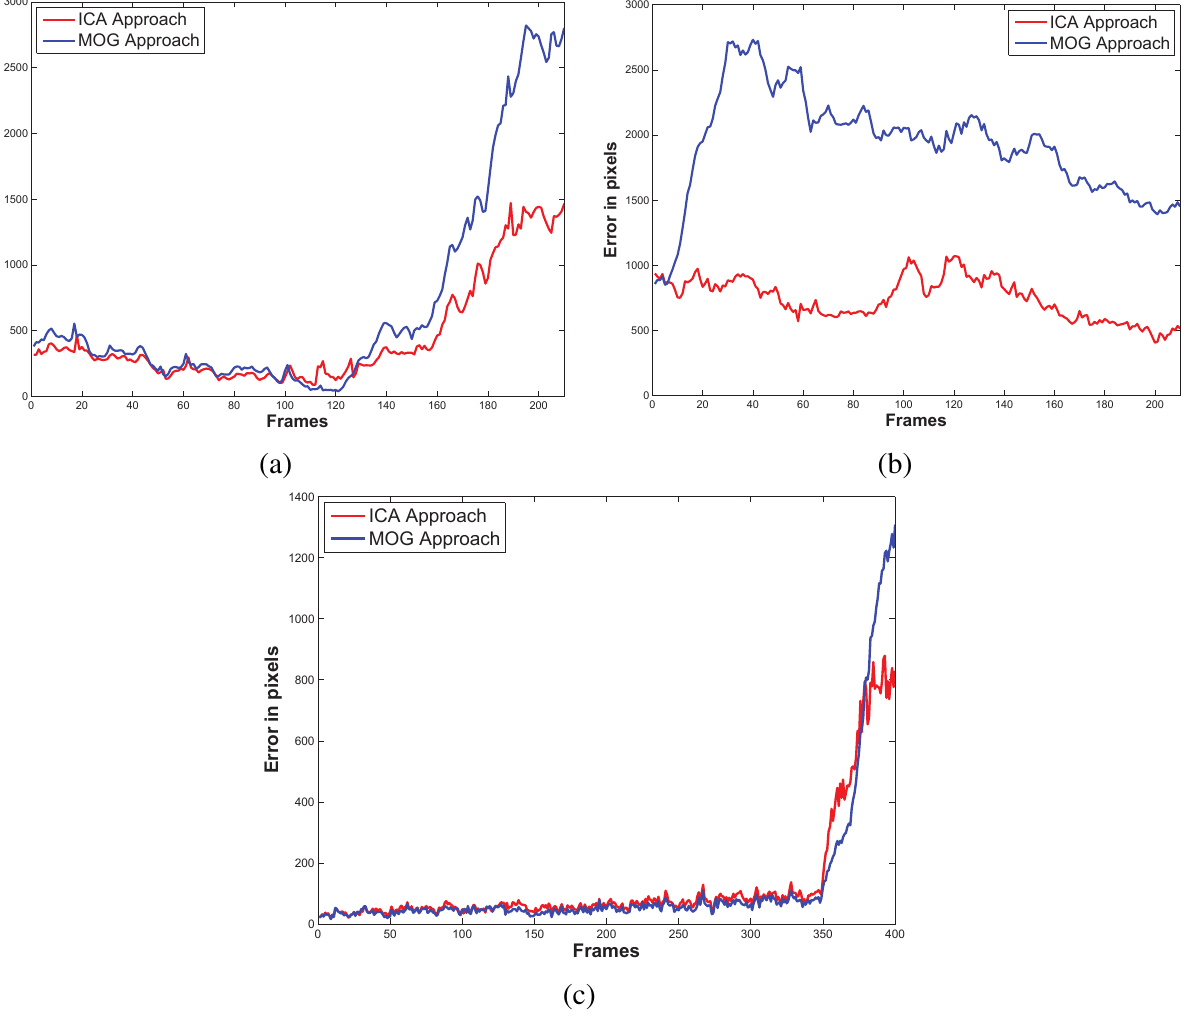
Figure 6. False-negative errors resulted after comparing ground truth against the proposal and the MOG approach. In the first train station sequence, (a) both errors are similar except for the end of sequence, where our approach has better accuracy for segmenting moving objects. In second train station sequence (b), the MOG approach is more sensitive to people shadows and reflection. Instead, the proposal always has better accuracy for detecting object moving. Finally, in (c) both measures are similar, except at the end of sequence, where our approach offers better accuracy than the MOG